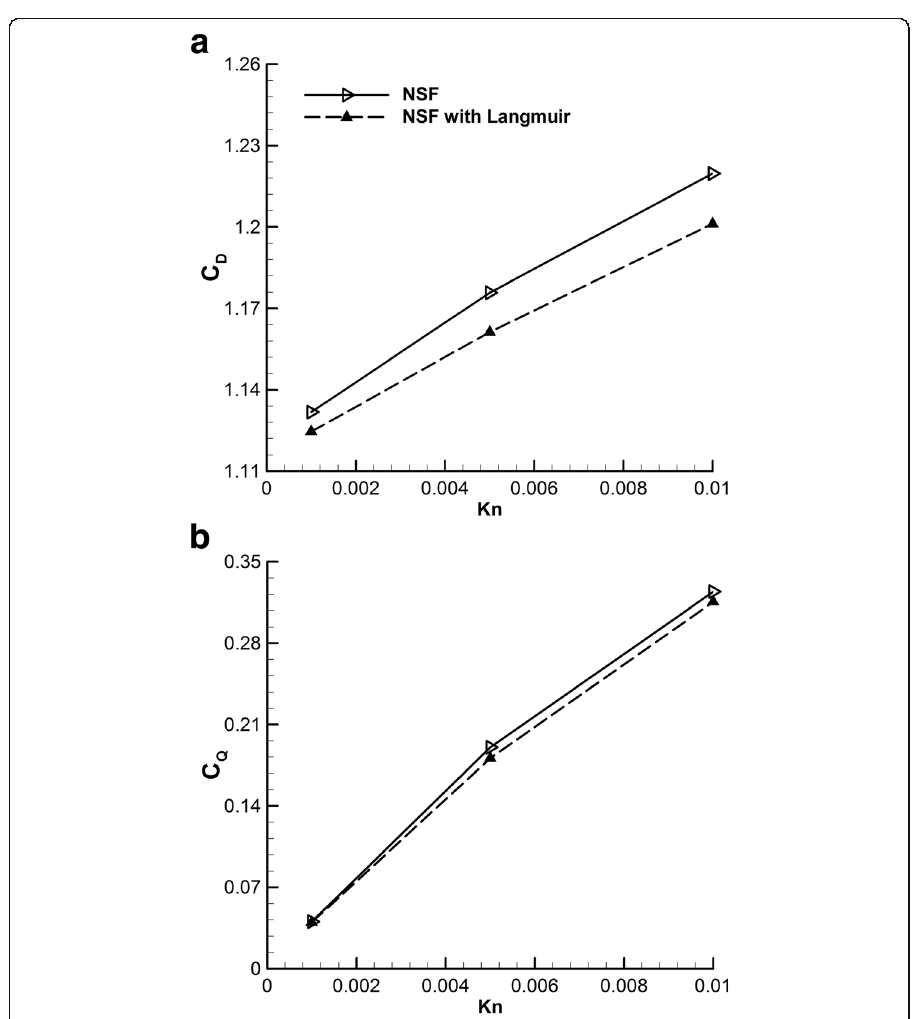
Fig. 21 Comparison of the aerothermodynamic coefficients for varying Knudsen numbers (0.001, 0.005, and 0.01) at M = 6: a drag coefficient, and b heat flux